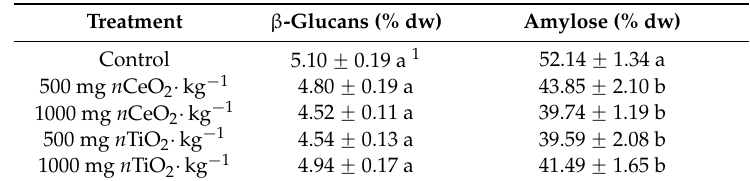
Table 3. β -Glucans and amylose concentration in barley kernels at ripening from main shoot grown in soil treated with none (Control), 500 mg n CeO 2 ¨ kg ´ 1 , 1000 mg n CeO 2 ¨ kg ´ 1 , 500 mg n TiO 2 ¨ kg ´ 1 and 1000 mg n TiO 2 ¨ kg ´ 1